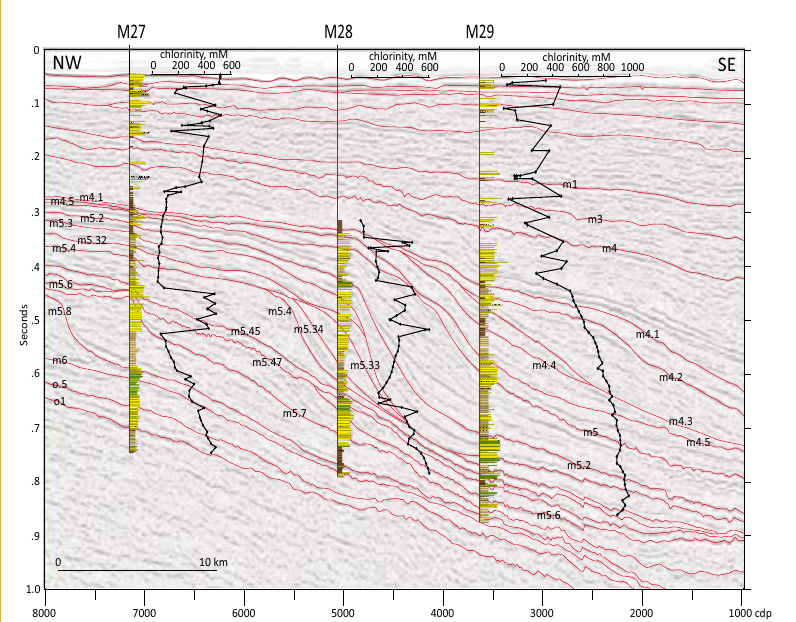
Figure 3. Seismic profile Oc270 line 529 that crosses the three Expedition 313 drill sites. Sediments between key Oligocene-Miocene sequence boundaries (labeled) and other mappable surfaces shown in red comprise many of the drilling targets. Recovered lithofacies (grain size in major units increases from left to right) and pore water chloride concentration are shown in travel time based on our preliminary acoustic travel time to depth-in-hole